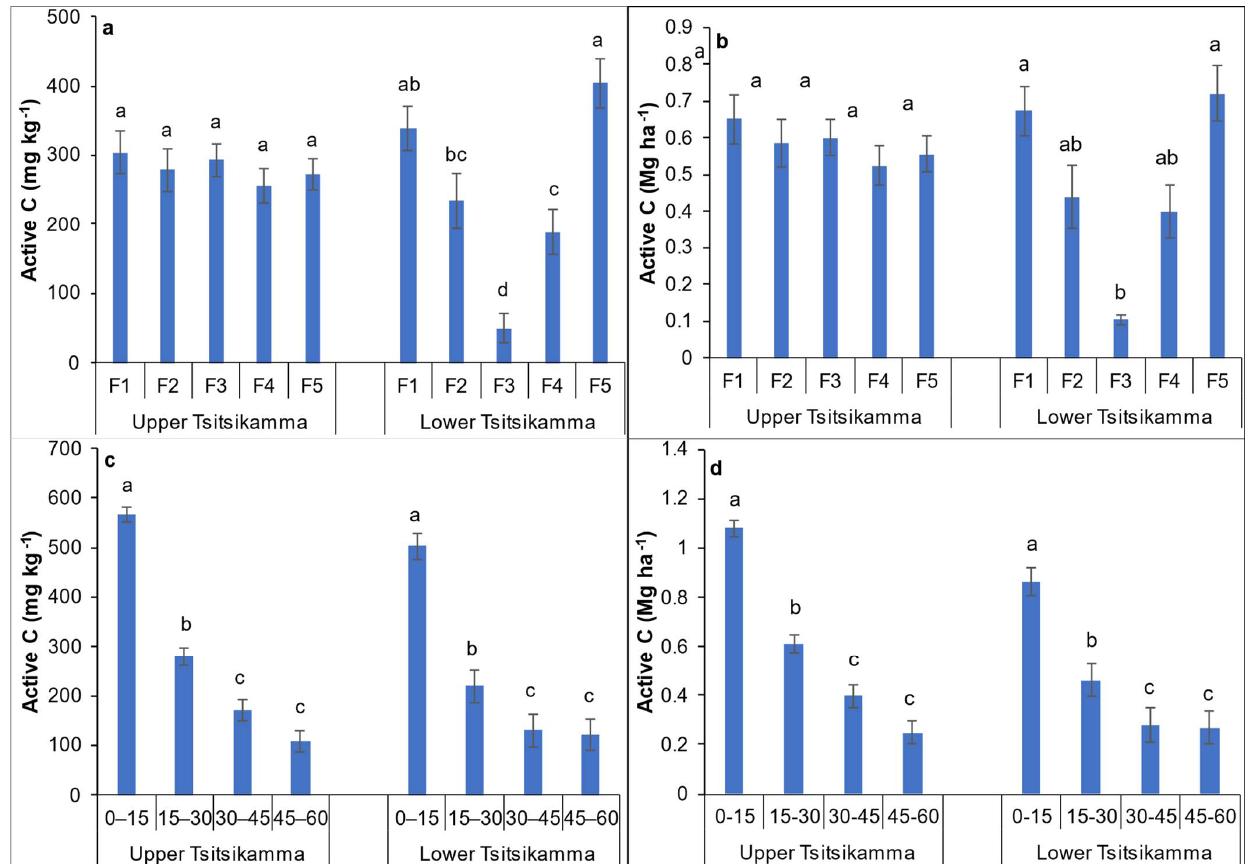
Figure 6. Effects of different farm management ( a , b ) and soil depth ( c , d ) on active C contents ( a , c ) and stocks ( b , d ) under mixed pastures in the Tsitsikamma dairy farms. Error bars indicate standard error of means. Different letters per site indicate significant difference.